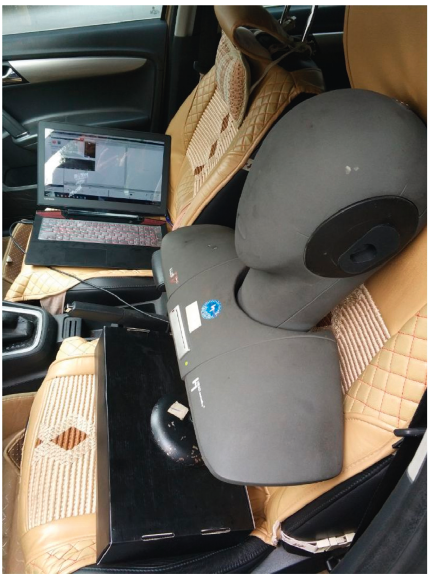
Figure 1: Collection of sound